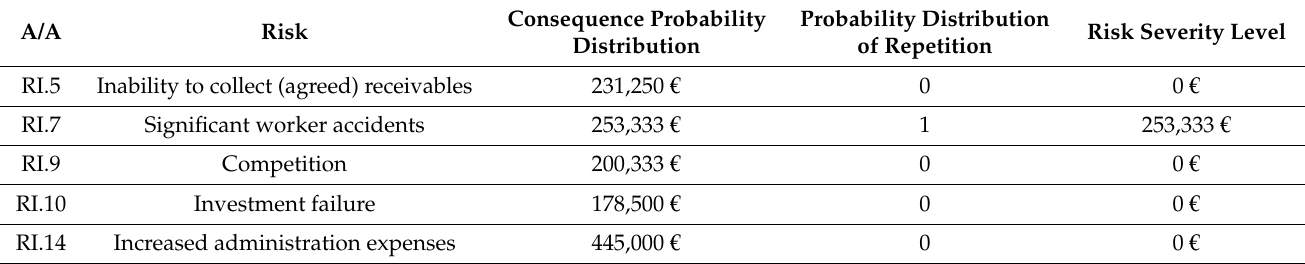
Table 6. Risk—Risk severity level of each of the risks individually.